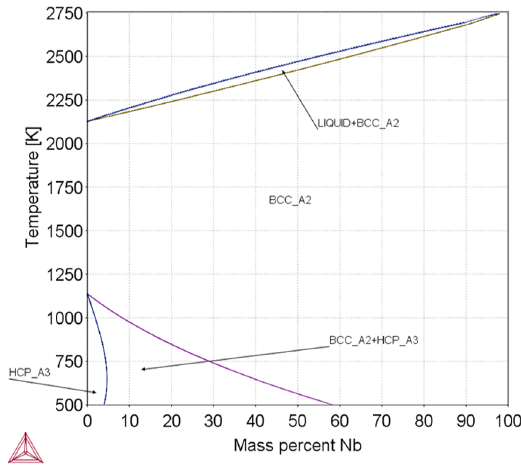
Figure 1. Isoplethal of 99Zr-xNb-(1-x)Mn, replacing Nb with